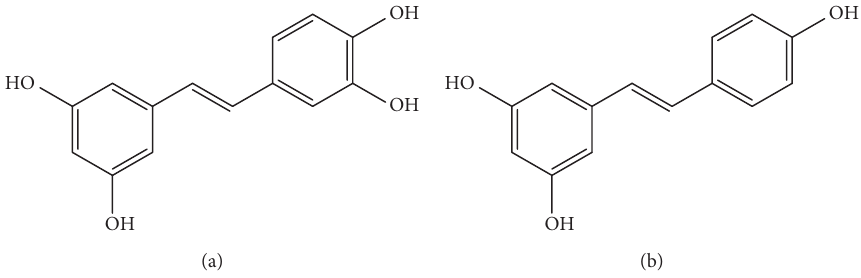
Figure 5: Chemical structures of piceatannol (a) and resveratrol (b). Table 2: MIC and MBC values of piceatannol and resveratrol against nine species of bacteria.